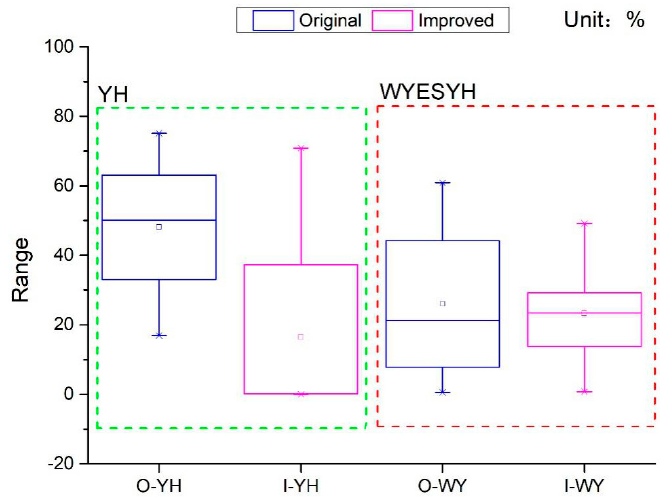
Figure 9. The monthly average water shortage range of two typical units.